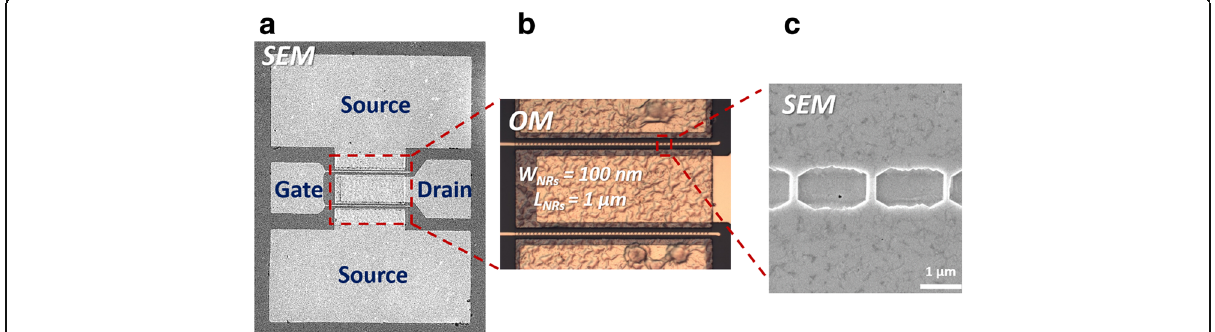
Fig. 2 a Top-view SEM image of the device; b top-view OM image of the device, revealing a channel width and length of 100 nm and 1 μ m, respectively; and c top-view SEM image of the channel